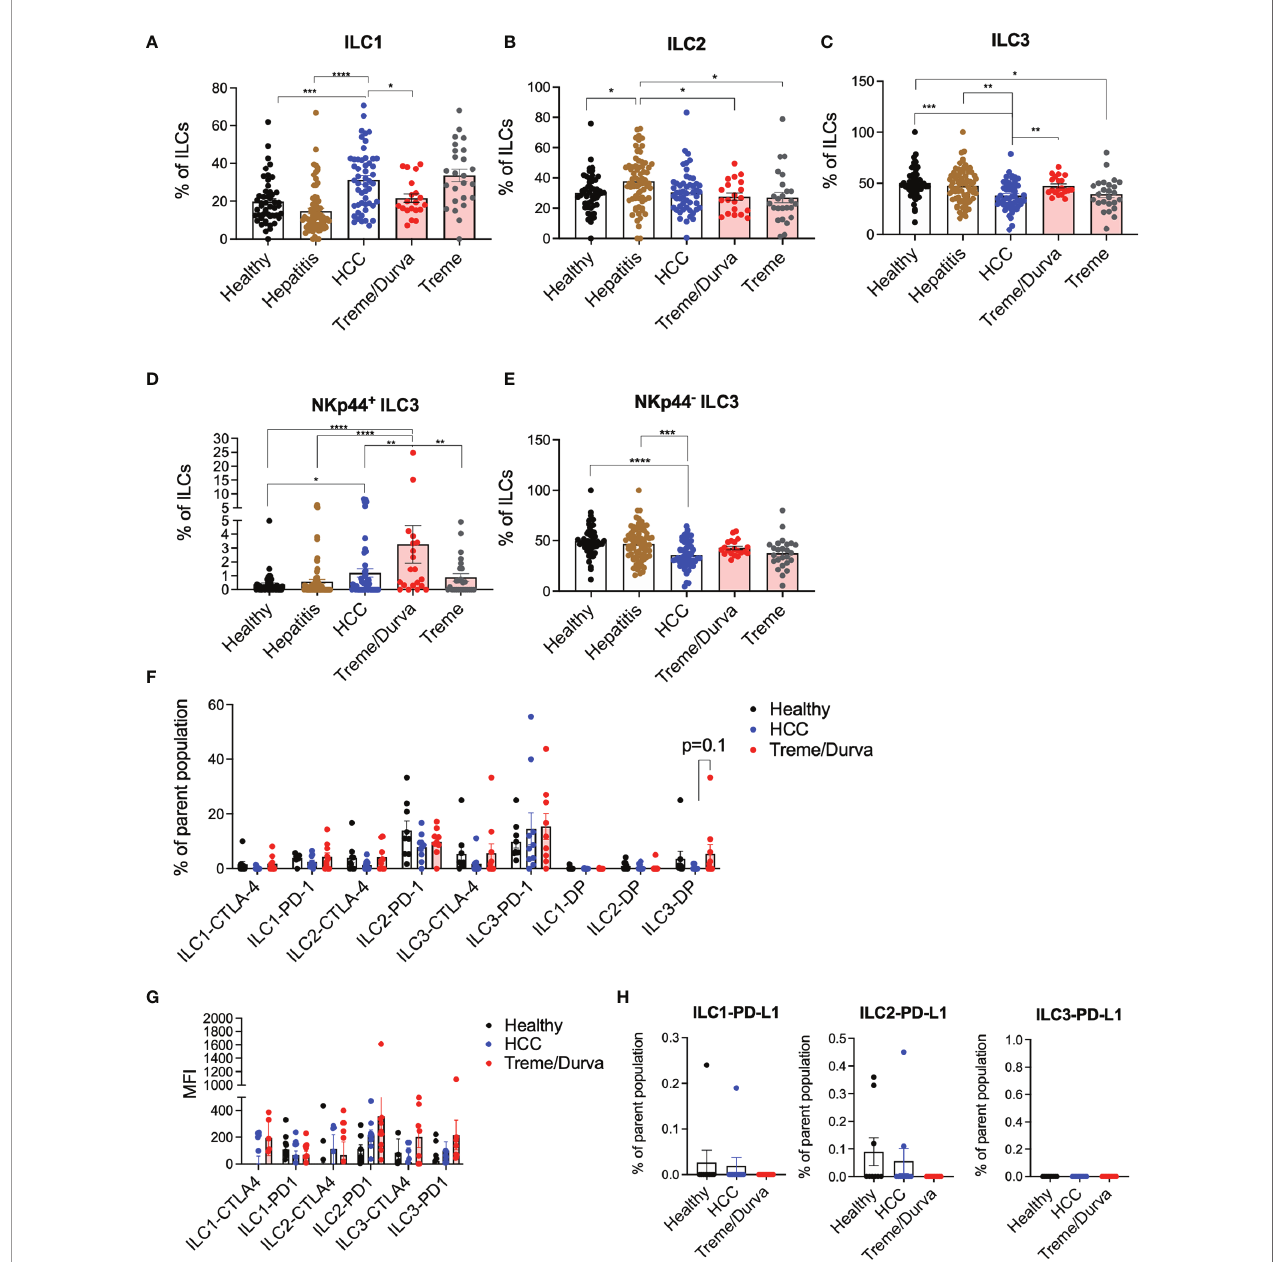
FIGURE 1 | (A – C) Flow cytometry (FC) data analysis presenting ILC1, ILC2, and ILC3 frequencies of CD45 + lin - CD127 + CD161 + ILCs. Lin is de fi ned as CD1a, CD34, CD3, TCR ab , TCR gd , CD14, CD19, CD16, CD94, CD123, BDCA2, FCeR1a. ILC1s are de fi ned as CD45 + lin - CD127 + CD161 + CRTH2 - c-KIT - ; ILC2s are de fi ned as CD45 + lin - CD127 + CD161 + CRTH2 + c-KIT +/- ; ILC3s are de fi ned as CD45 + lin - CD127 + CD161 + CRTH2 - c-KIT +. Cohorts include healthy donors (n = 57), patients with hepatitis (n = 70), patients with HCC before immunotherapy (n = 54), and patients after receiving up to four cycles of their immunotherapy checkpoint inhibitor (ICI) regimen of either combination of tremelimumab and durvalumab (treme/durva, n = 20) or tremlimumab only (treme, n = 26). (A) Bar plots showing ILC1 frequency in individual cohorts. (B) Bar plots showing ILC2 frequency in individual cohorts. (C) Bar plots showing ILC3 frequency in individual cohorts. (D) Bar plots showing frequency of NKp44 + ILC3s of ILC3s. (E) Bar plots showing frequency of NKp44 - ILC3s of ILC3s. (F) Bar plots showing frequency of ILCs expressing CTLA-4 or PD-1 or CTLA-4/PD-1 double positive (DP) cells by subgroup and separated by cohorts. (G) Bar plots showing median fl uorescence intensity of CTLA-4 and PD-1 on ILC subgroups separated by cohorts. (H) Bar plots showing frequency of ILCs expressing PD-L1 by subgroup and separated by cohorts. Signi fi cance: *=p < 0.05, **=p < 0.01, ***=p < 0.001, ****p <